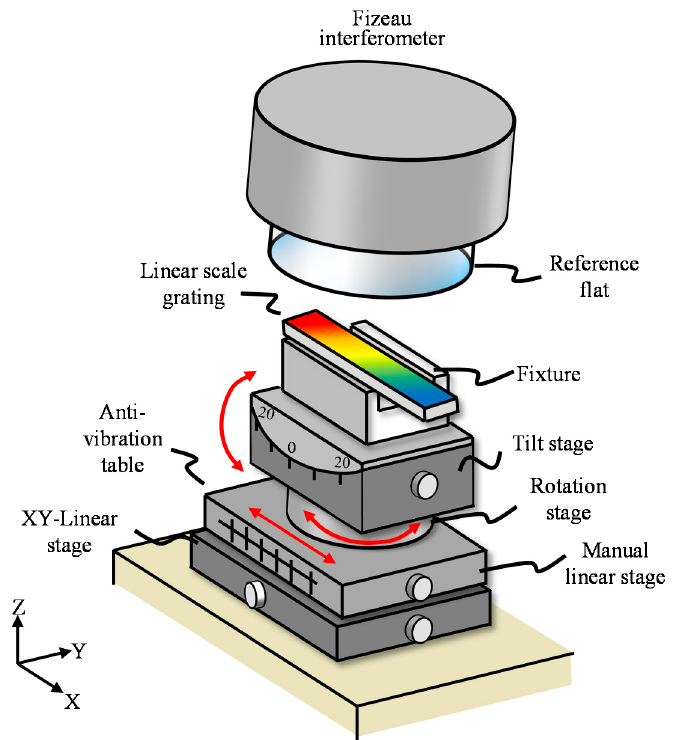
Figure 9. Experimental setup with a commercial Fizeau interferometer.